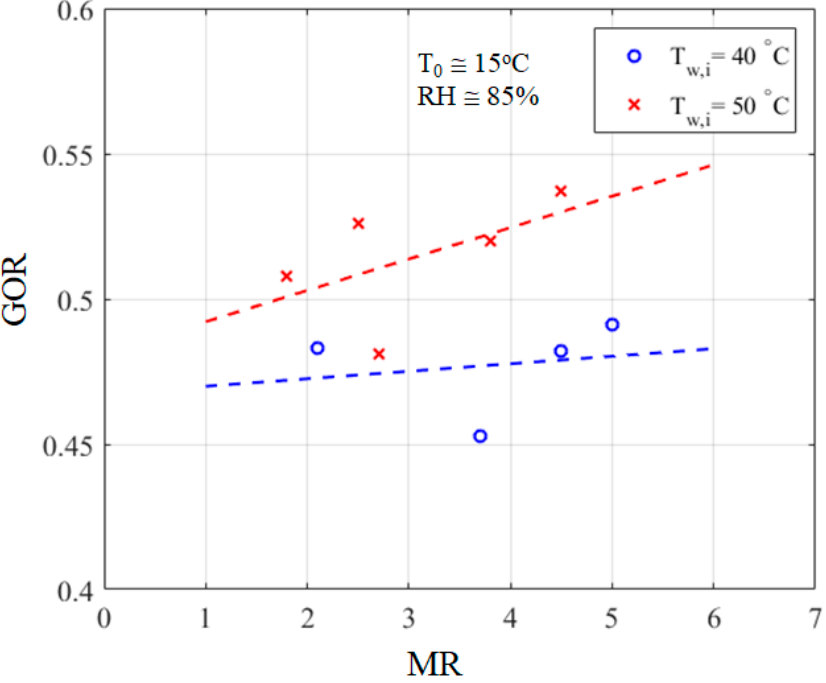
Figure 7. Gained output ratio ( GOR ) as a function of MR .